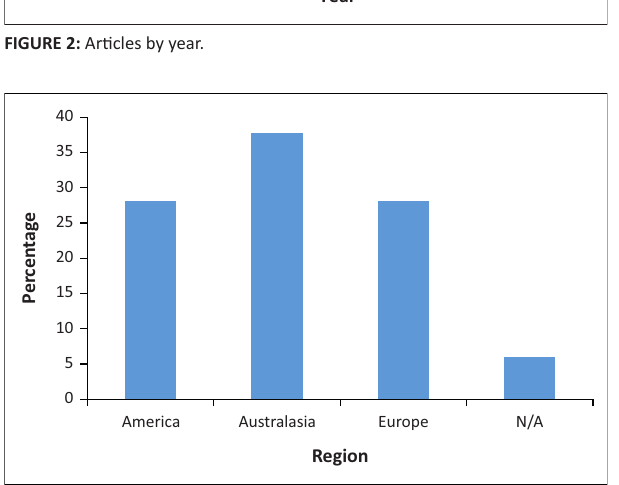
FIGURE 2: Articles by year.